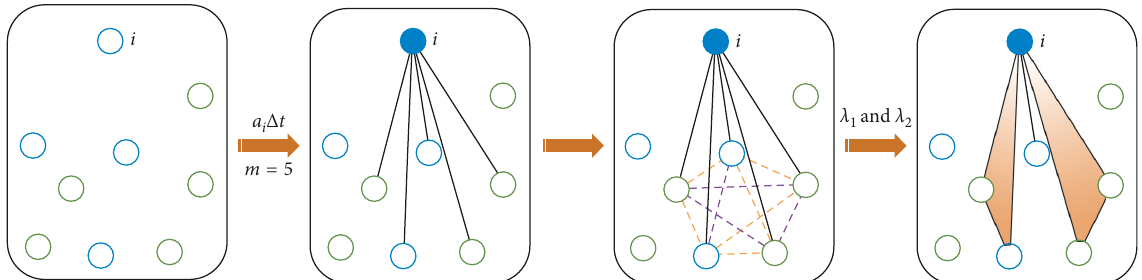
Figure 1: The CADmodel.Inthe network,therearetwotypesof nodes,withtheblue(green)circlesrepresentingtype A ( B ).Ateachtimestep,atype A node i becomes active (labeled with solid circle) with the probability a i Δ t . Once the node i is active, it interacts with m neighbor nodes randomly chosen from allthe other nodes inthe network. The purple (orange) dotted line denotesthe possible interaction between two neighbor nodes withthe